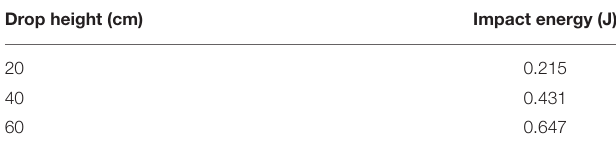
TABLE 1 | Experimental drop height and energy